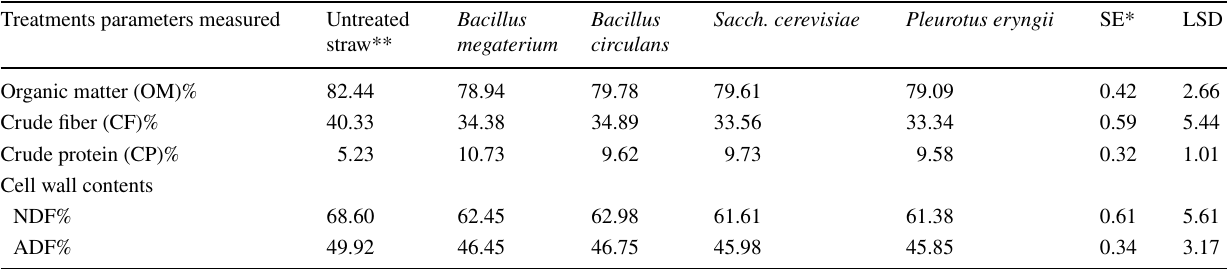
Table 5 Effect of different microbial inoculants on the nutritional quality of rice straw